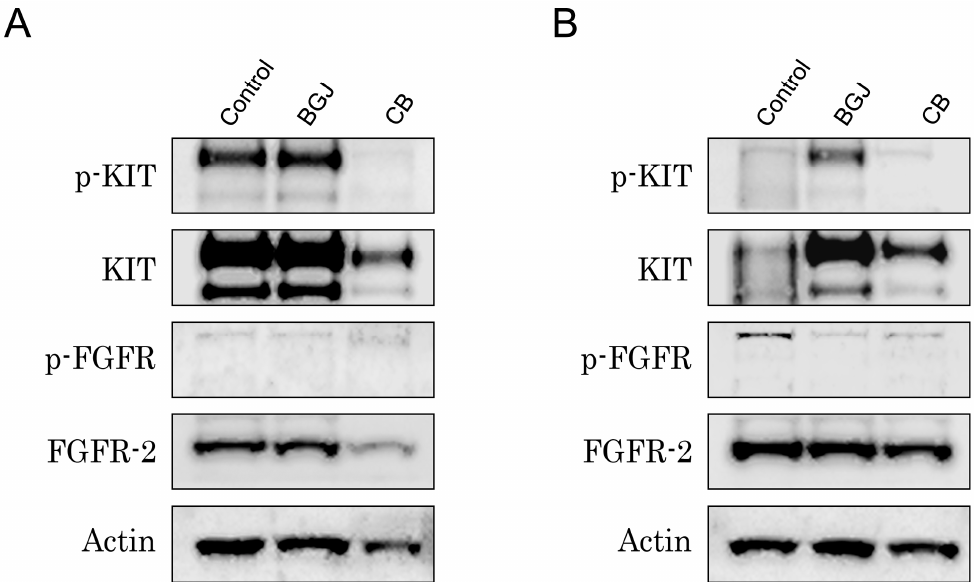
Figure 5. The effects of FGFR-inhibitor BGJ398 and cabozantinib (CB) on FGFR and KIT-signaling in IM-naive ( A ) and -resistant ( B ) GIST T-1 cells. Immunoblot analysis for total and phosphorylated forms of KIT and FGFR in non-treated (control), BGJ398- or CB-treated GIST T-1 and GIST T-1R cells. Actin stain was used as a loading control.